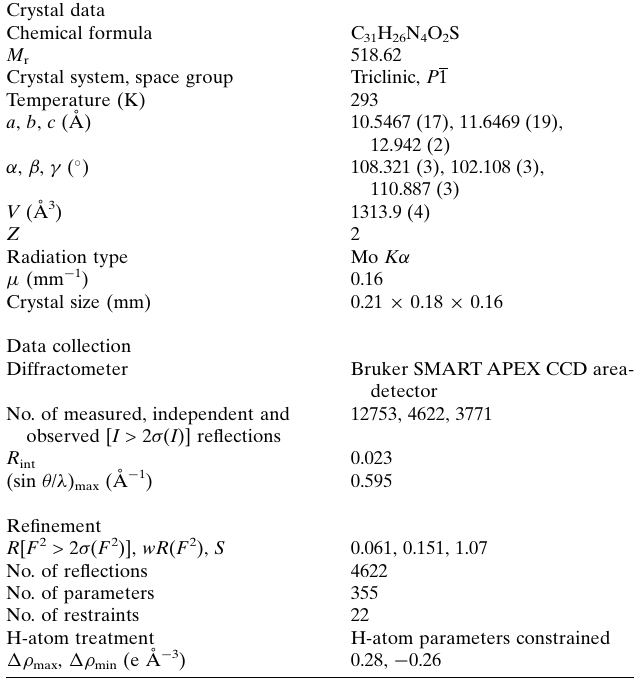
Crystal data Chemical